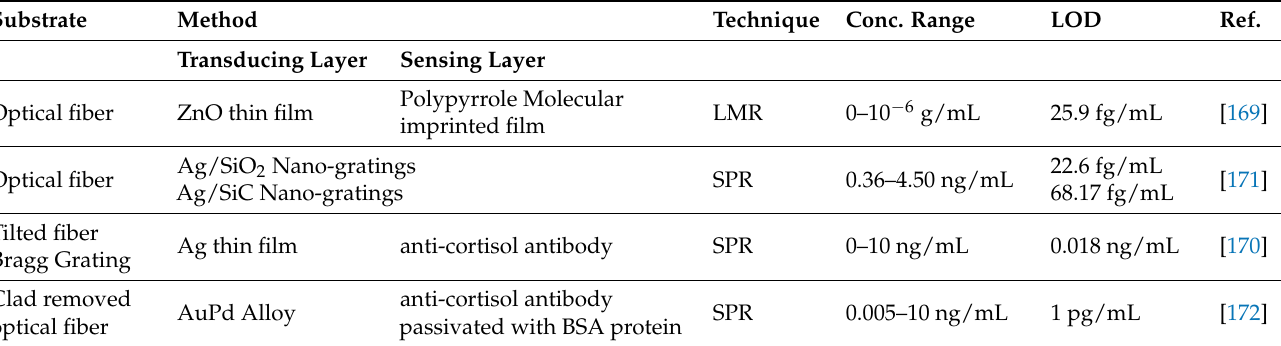
Table 5. A comparison of optical fiber Cortisol sensors reported in